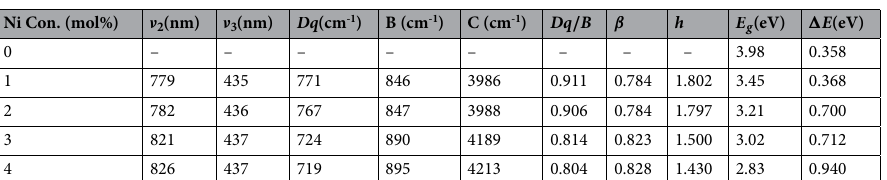
Table 1. Ligand field parameters, optical band gap, and Urbach energy of produced glasses.